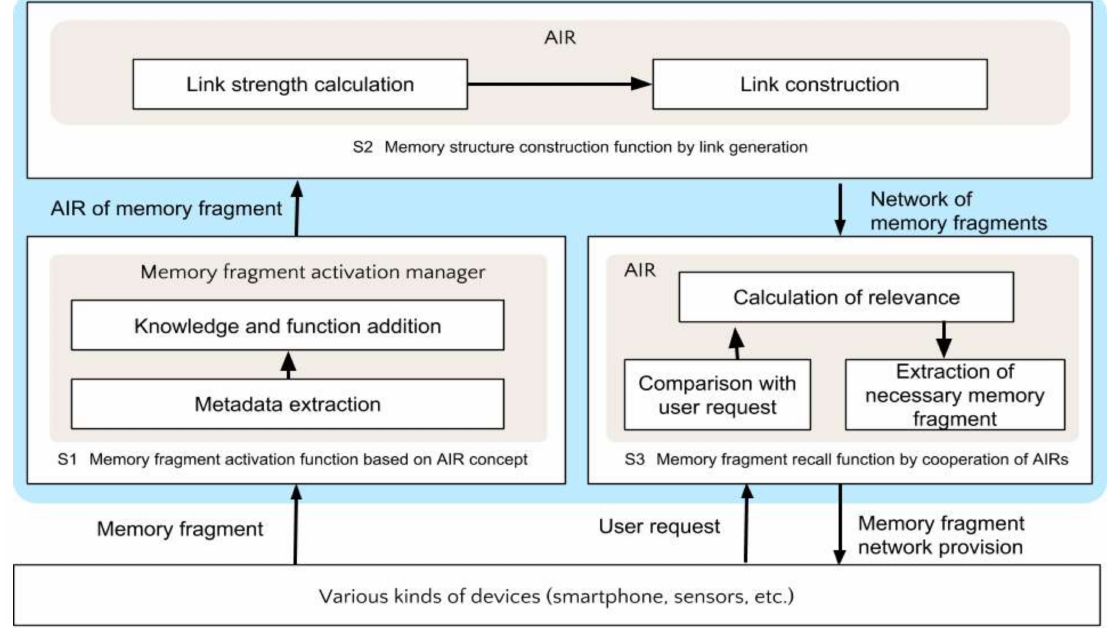
Figure 3. Processing flow of the memory recall support system based on the active acquisition and accumulation of memory